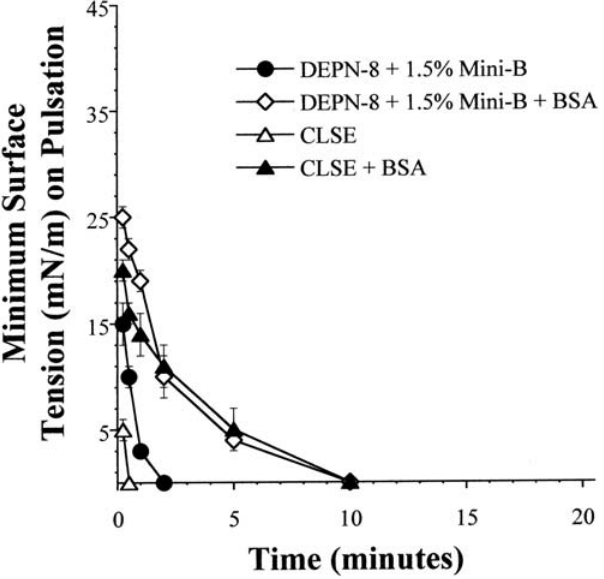
Figure 5. Quasi-static surface activity of DEPN-8 + 1.5% or 3% Mini-B compared to CLSE on the captive bubble surfactometer. Minimum and maximum surface tensions are shown for DEPN-8 + 1.5% or 3% by weight Mini-B compared to CLSE on a captive bubble surfactometer during slow compression (10 cycles over 90 min including a 2 min pause between each cycle). Surface tension values are Mean 6 SEM for at least three separate experiments. See text for details.